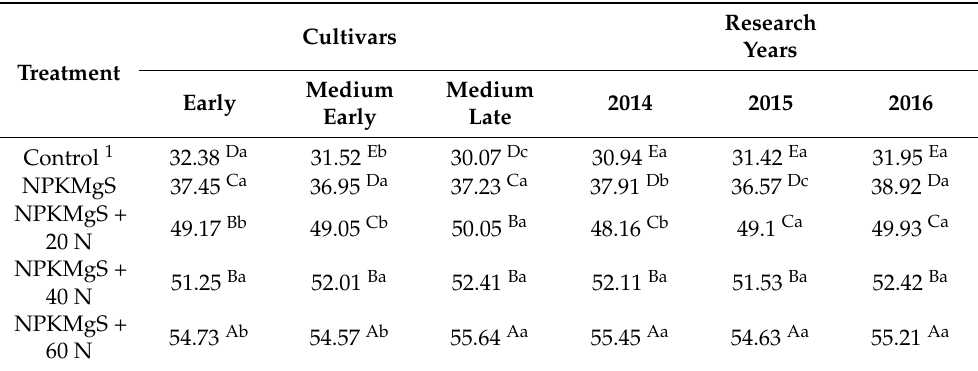
Table 4. Urease activity in soil (mg NH 4 -N h –1 kg –1 DM).